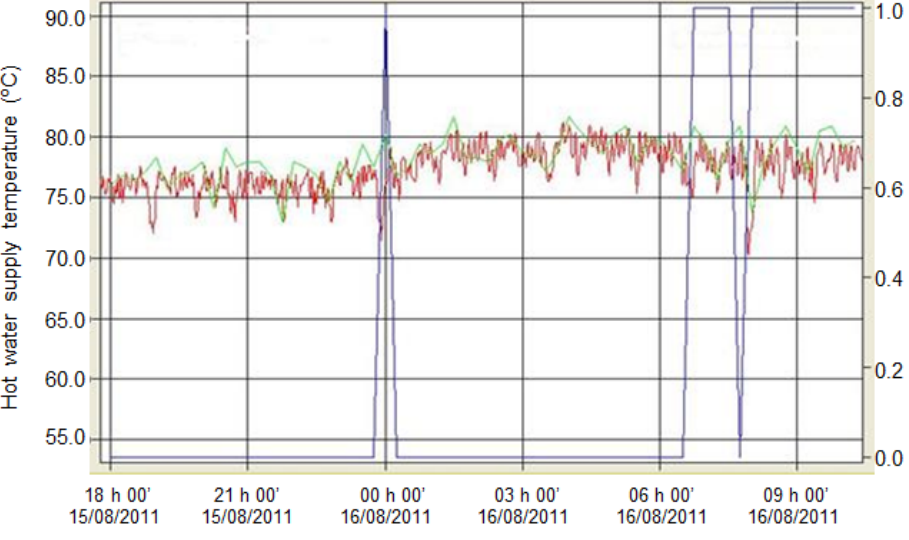
Figure 11. Boiler 5: Hot water supply temperature evolution (°C) implementing actions 1, 2, and